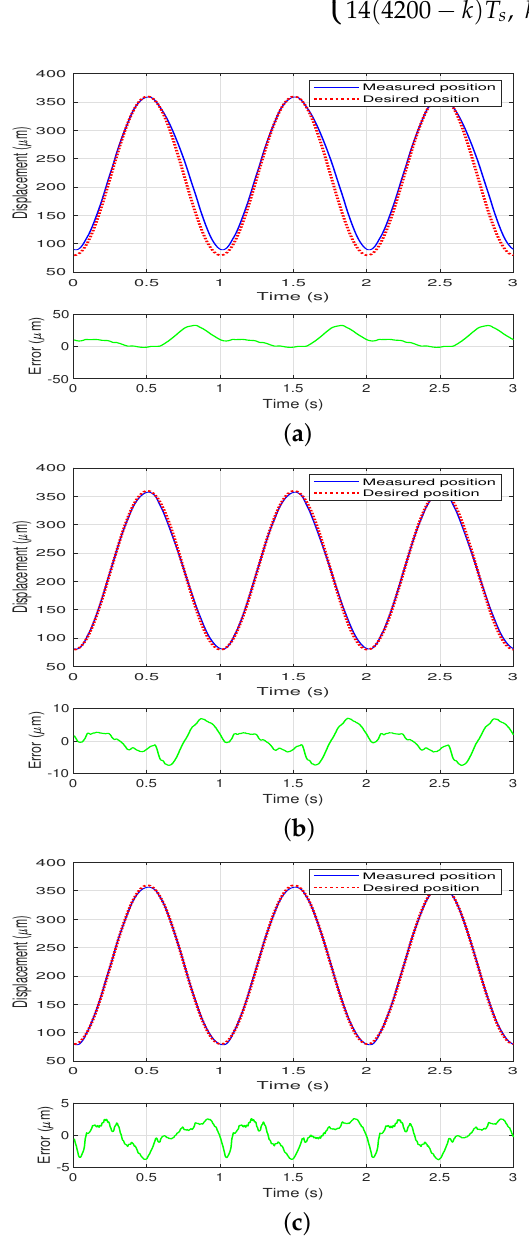
Figure 6. Compensation results at a fixed amplitude using the PI, MPI, and the DPI model, respec- tively, the dashed line represents the desired position while the solid line represents the measured actual position. ( a ) Compensation results at a fixed amplitude using the PI model. ( b ) Compensation results at a fixed amplitude using the MPI model. ( c ) Compensation results at a fixed amplitude using the DPI